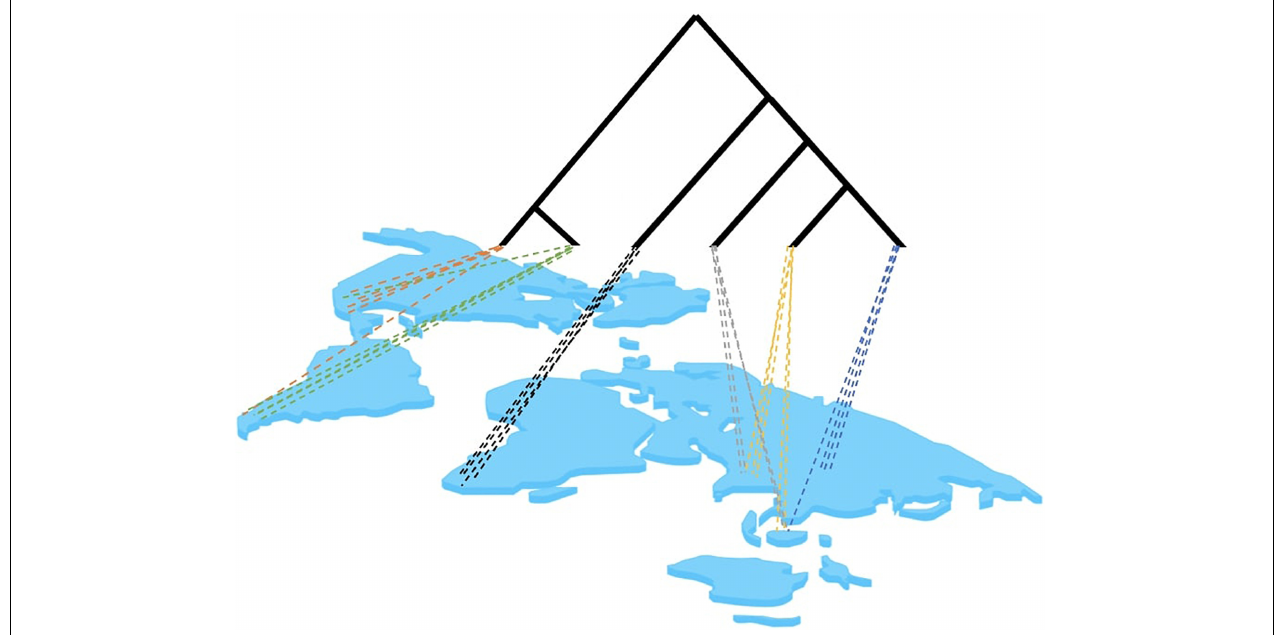
FIGURE 3 | Hypothetical distribution of lineages in a multi-site analysis. Site-based sampling may only capture a certain proportion of the full tree, depending on the level of geographic structure of lineages and the geographic proximity of sampling sites. Colors represent closely related lineages. Note that particular lineages at any hierarchical level may be captured across multiple sites. This overlap can be expected to increase with closer biogeographic proximity of sampling sites and with deeper origin of lineages near the base of the tree.